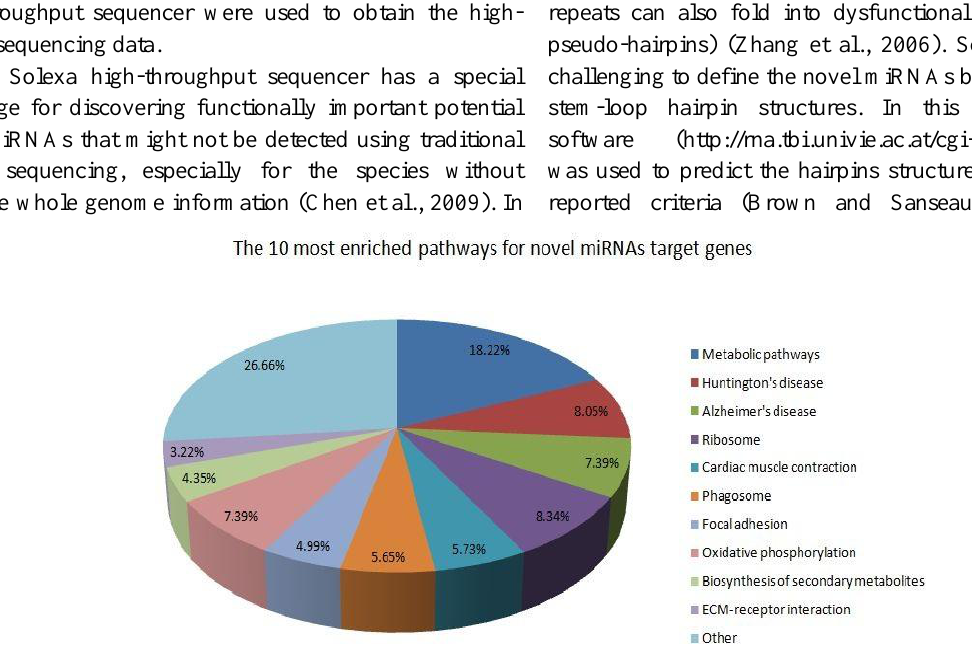
Figure 4. Summary of KEGG pathway for predicted target genes. Approximately 75% of the genes were annotated to the 10 most enriched pathways, 18.22% of the genes were committed to metabolic pathways, more than 15% of genes were involved in disease pathways, and approximately 8% of genes were involved in the Ribosome pathway or Oxidative phosphorylation